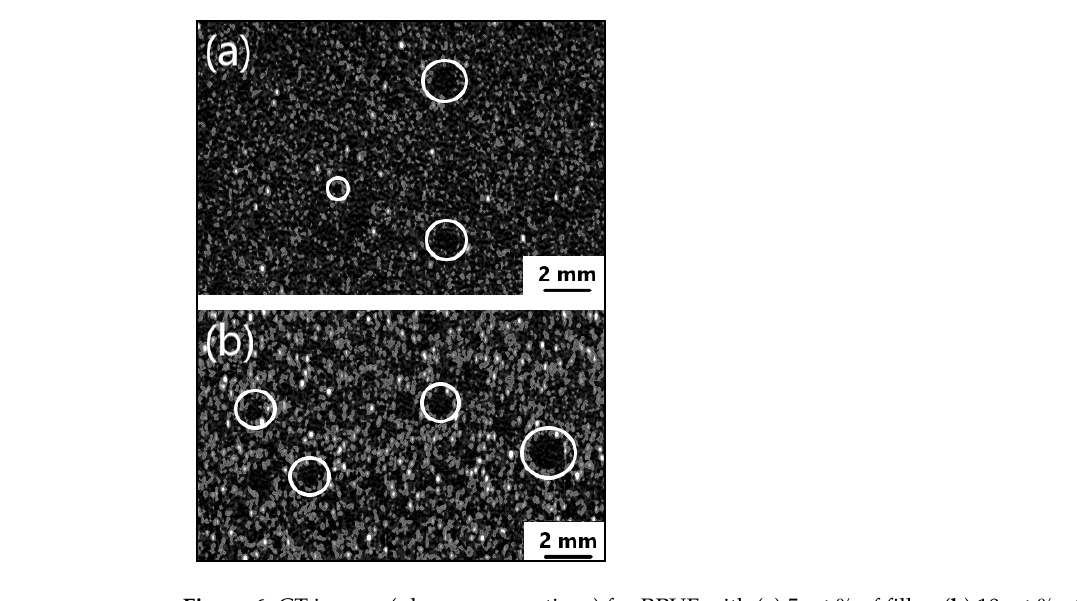
Figure 6. CT images (plane cross-sections) for RPUF with ( a ) 5 wt.% of filler; ( b ) 10 wt.% of filler.